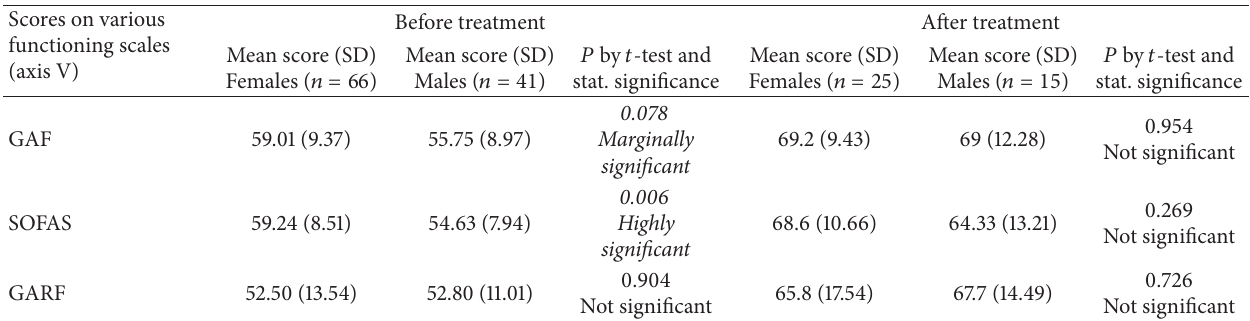
Table 4: Scores of level of functioning in major depressive disorder across